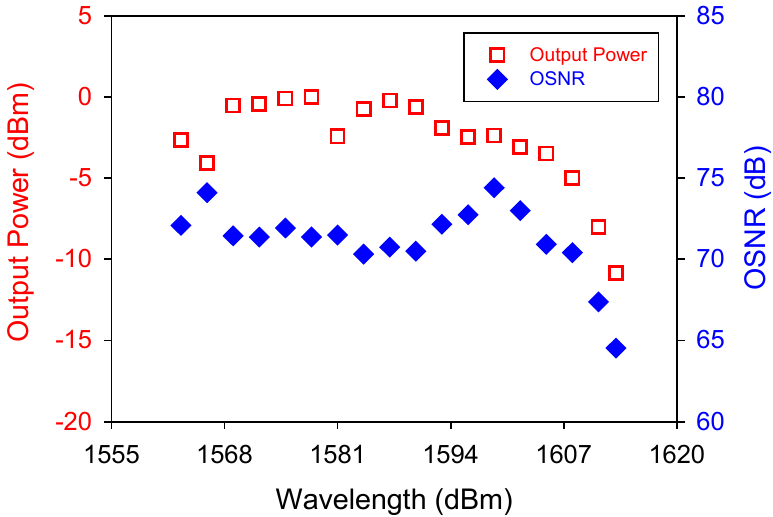
Figure 3. Observed output wavelength and OSNR of the presented EDF compound-ring laser in the achievable bandwidth of 1563.0 to 1613.0 nm.